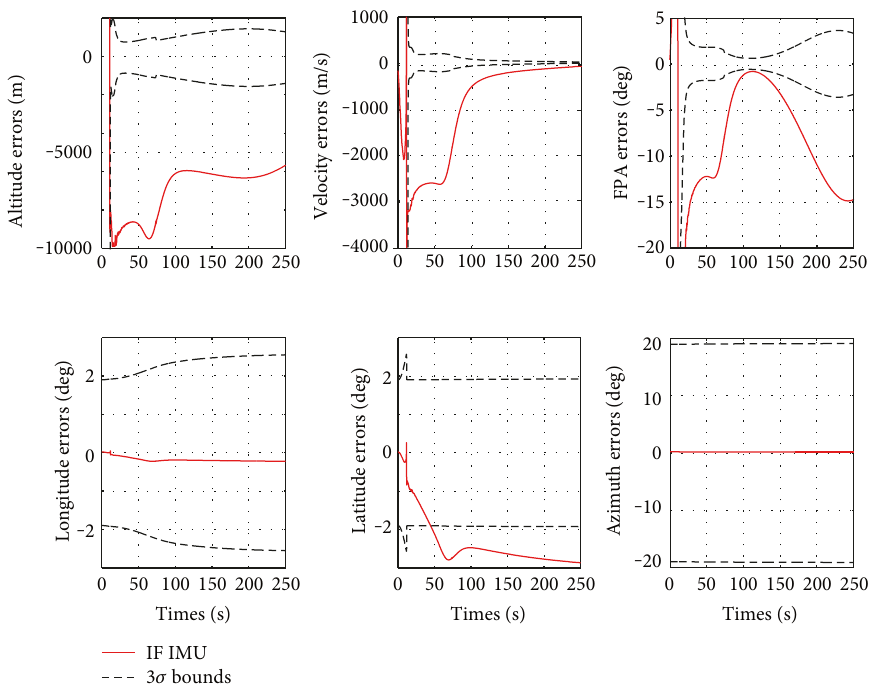
Figure 7: State estimate errors and 3 σ bounds for the default IMU navigation